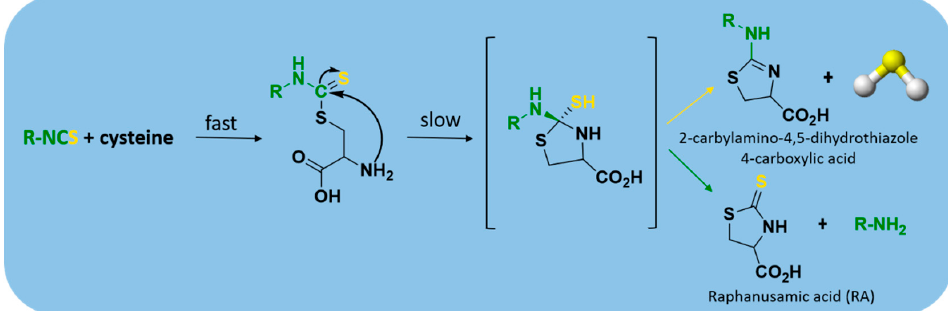
Figure 6. The mechanism of H 2 S release from isothiocyanates.